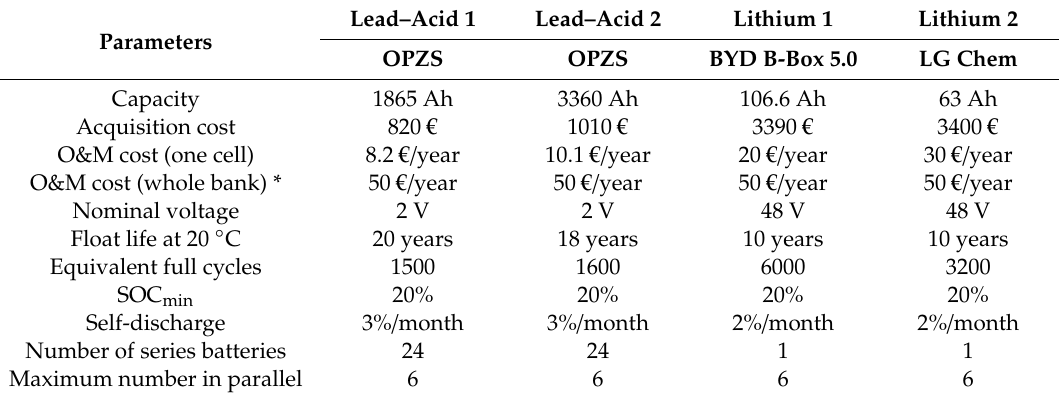
Table 7. Batteries used in the optimization.